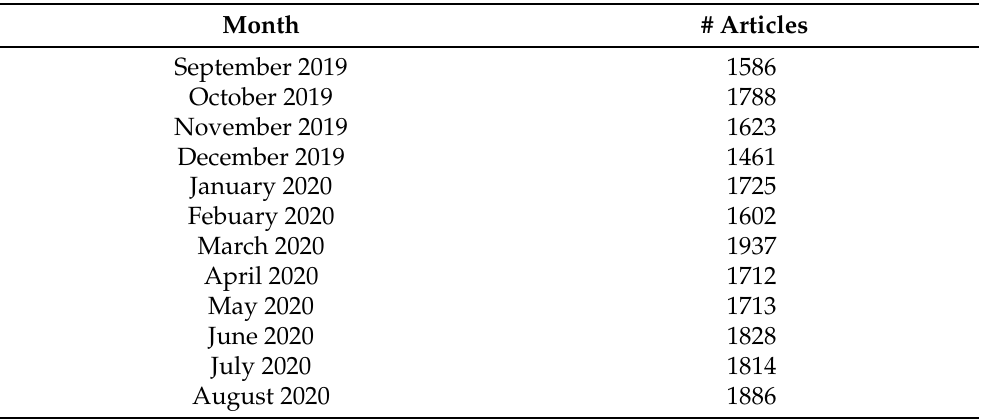
Table 3. New York Times news corpus grouped by month and number of articles. This corresponds to the number of articles per slice of input tensor.